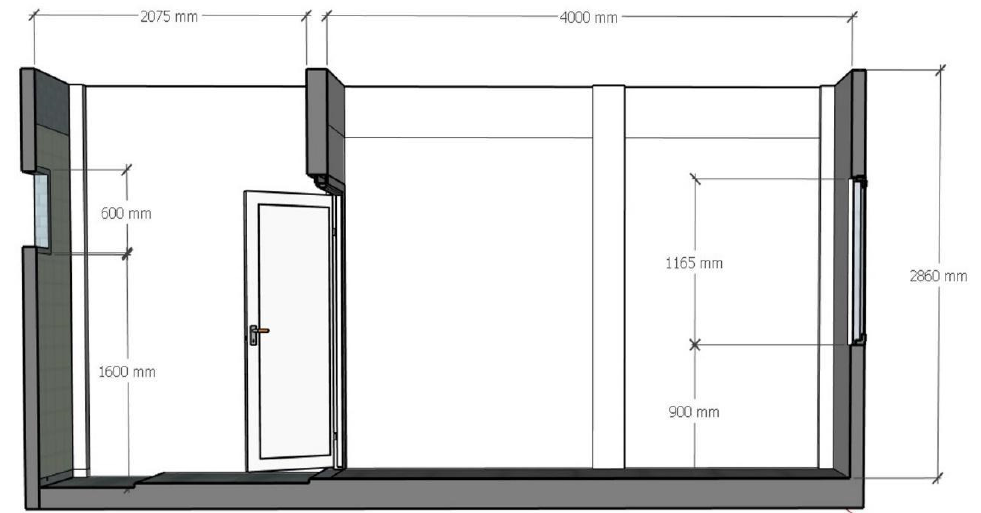
Figure 4. Section across the modelled master bedroom and attached bathroom.